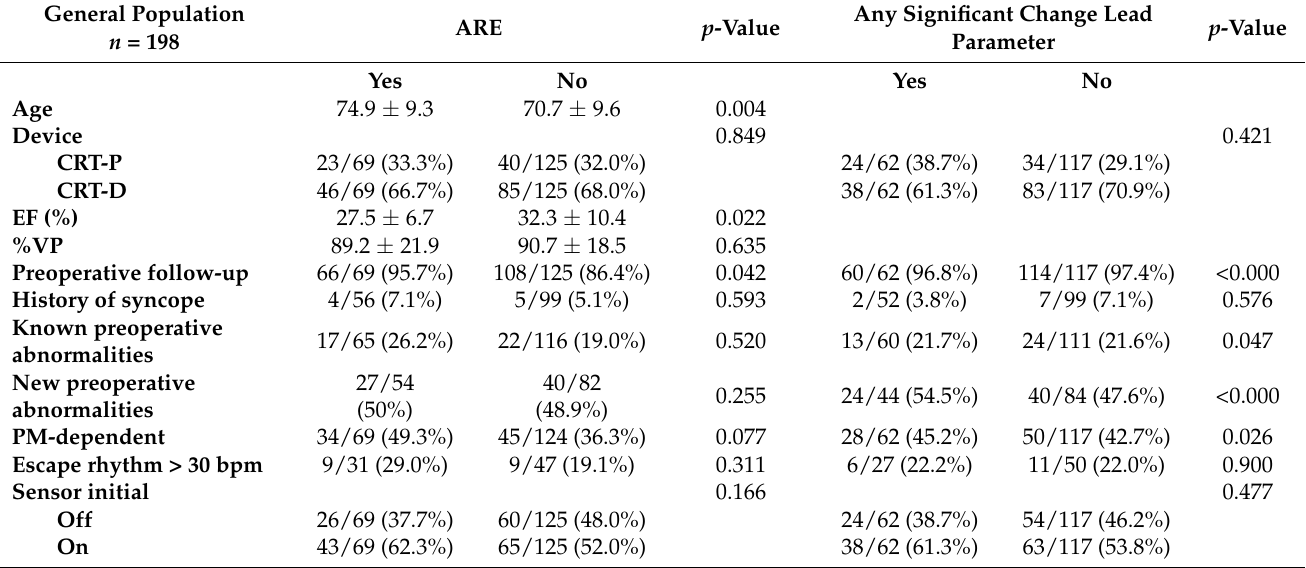
Table 8. Basic statistics for ARE and significant changes in the lead